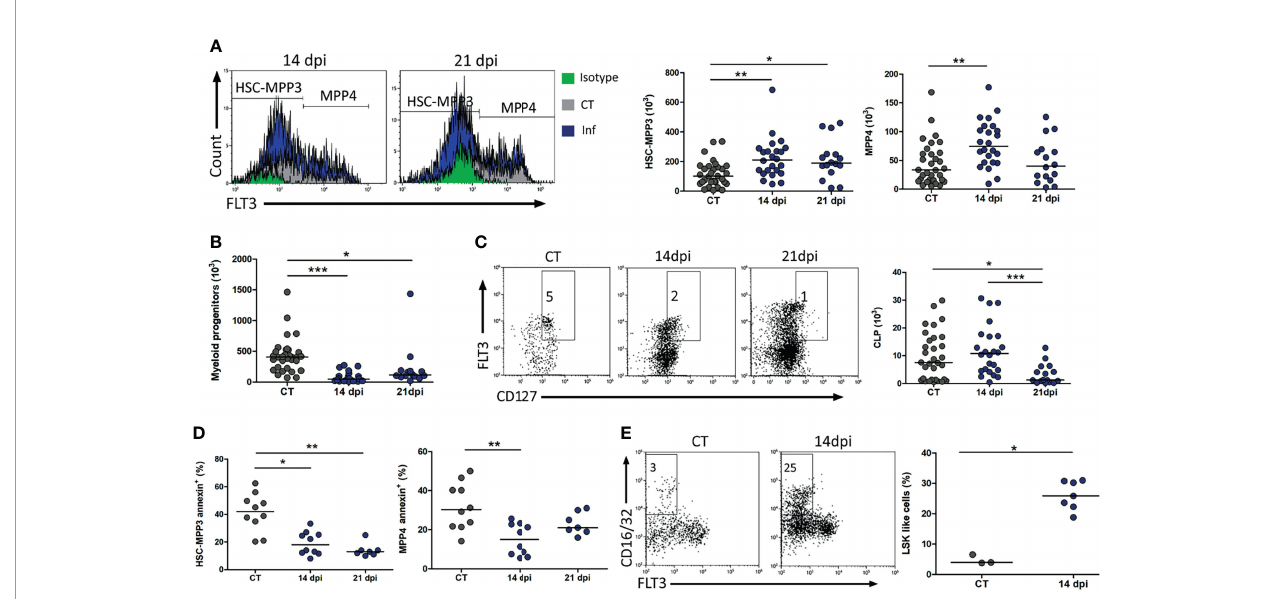
FIGURE 3 | Augmentation of HSCs and MPPs in forward oral Trypanosoma cruzi infection without parallel CLPs and myeloid progenitor expansion in bone marrow occur concomitantly with LSK-like cells increase. (A) Representative histogram of HSCs FLT3 − and MPPs FLT3 + gated within Lin − SCA-1 + c-kit + CD127 − cells and absolute cell number of HSCs (Lin − SCA-1 + c-kit + FLT3 − CD127 − ) and MPPs (Lin − SCA-1 + c-kit + FLT3 + CD127 − ) at 14 and 21 dpi. (B) Absolute cell number of myeloid progenitors at 14 and 21 dpi. (C) Representative dot plot of CLPs FLT3 versus CD127 gated within Lin − SCA-1 + c-kit + cells and absolute cell number of CLPs (Lin − SCA-1 + c-kit + FLT3 + CD127 + ) at 14 and 21 dpi. (D) Annexin-de fi ned cell death rate on HSCs and MPPs at 14 and 21 dpi. (E) Representative dot plot of CD16/ 32 + gated within Lin − SCA-1 + c-kit + cells and absolute cell number of LSK-like cells (Lin − SCA-1 + c-kit + CD16/32 + ) at 14 dpi. Representative dot plot of increased SCA- 1 expression gated within Lin − cells shown previously in dot plot in Figure 2C . Bars indicate median; circle depicts individual mice. The data are representative of pooled results from 5 independent experiments with 2 – 7 animals per analysis at 14 dpi and 4 independent experiments with 2 – 5 animals per analysis at 21 dpi (A – C) . Statistical analyses of cell death were pooled from 2 independent experiments with 3 – 7 animals per analysis at 14 dpi and 1 independent experiment with 7 animals at 21 dpi. All CT animals were grouped in the same set. Non-parametric, Kruskal – Wallis ANOVA test with Dunn ’ s multiple comparison test [ (A – C)